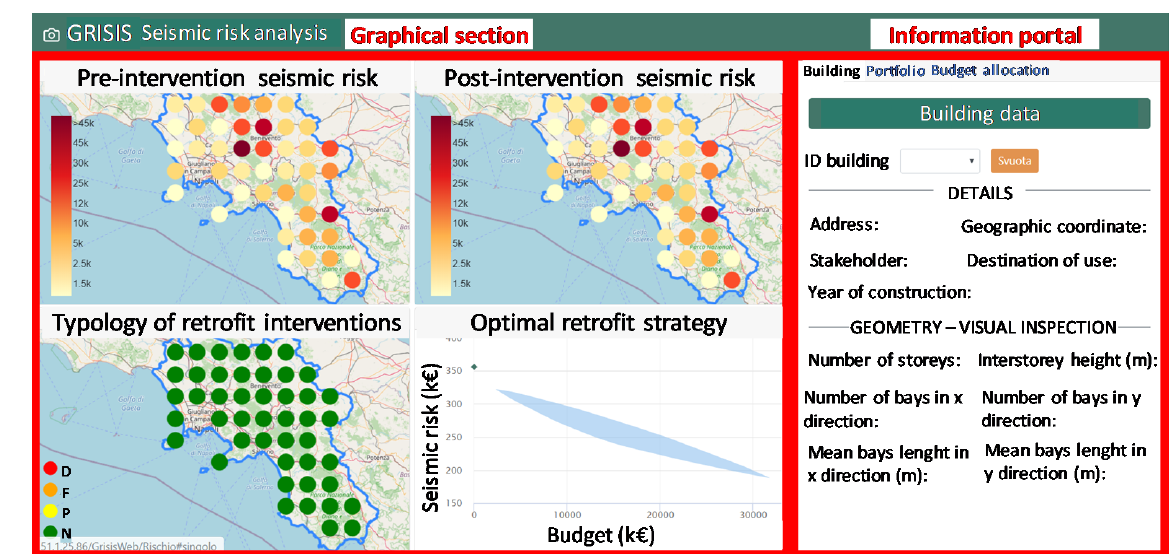
Figure 6. Web-platform analyzing the seismic risk of a buildings portfolio and prioritizing retrofit interventions to mitigate it.